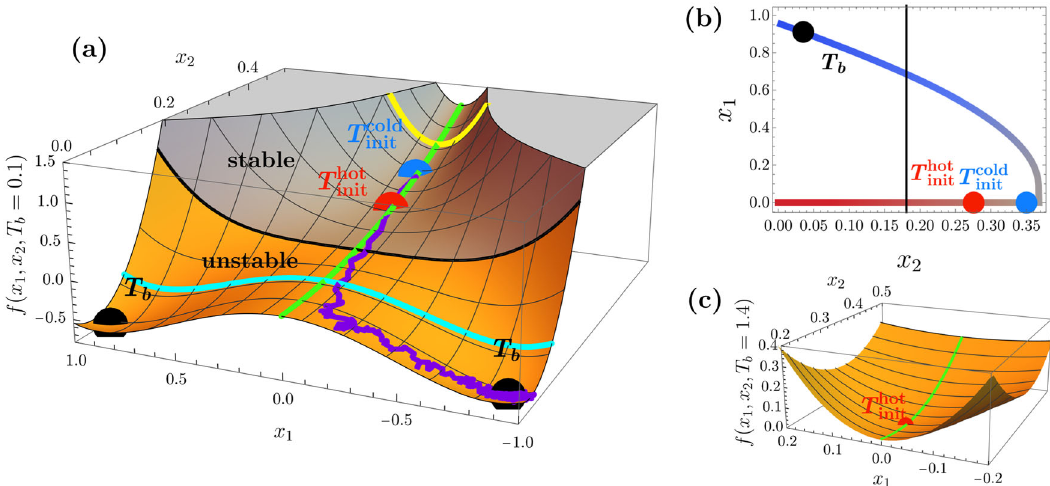
Fig. 1 Mpemba through a phase transition. A concrete example of a free energy demonstrating both a phase transition occurring after a fi nite time and a Mpemba effect. The explicit form of the free energy f ( x 1 , x 2 ; T b ) is given in Eqs. (9), (10), (13), (14)). a The free energy surface evaluated at T b = 0.1 < T c . ! eq ð T Þ cold The green line, x 1 = 0, corresponds to all equilibrium values at the disordered phase. The purple line is an example of a trajectory which starts at x init (the blue dot), and follows Eq. (3) for some random noise realization. The stability in the x 1 direction along the x 1 = 0 line changes throughout the trajectory — the black line separates between the stable region (gray) and the unstable region (orange). Crossing this line de fi nes the phase transition, and it happens ! eq ð T Þ and x ! eq ð T cold Þ , hot at a non-zero fi nite time. The red and blue dots correspond to hot and cold initial equilibria in the disordered phase, i.e., to x init init respectively. The black dots correspond to the symmetric equilibria of the bath temperature T b = 0.1. Observing the trajectory governed by the free energy surface, it is clear that as the colder initial condition must fi rst reach the hotter initial condition, the colder initial condition takes more time, and so this ! eq ð T Þ system exhibits the Mpemba effect. b The equilibrium line x of the free energy determined by Eq. (2). Temperatures range from T = 0 (blue) to T = ∞ (red). The black, blue, and red dots correspond the same dots of panel a , i.e., to x ! eq ð T Þ ; x ! eq ð T cold Þ and x ! eq ð T hot Þ , respectively. It is clear that the b init init hotter initial condition is closer to T b than the colder initial condition. The black line corresponds to the black line in panel a , namely it separates the stable region and the unstable regions at T b = 0.1. c The free energy surface evaluated at T b = 1.4 > T c . This temperature is denoted as T hot and therefore the init ! ; T Þ is obtained by x ! eq ð T hot Þ as seen in the plot. The green line corresponds to the symmetry line x = 0. It is demonstrated that x = 0 is hot minimum of f ð x 1 1 init init stable for all values of x 2 at this temperature. The stability of x 1 = 0 holds for all temperatures above T c